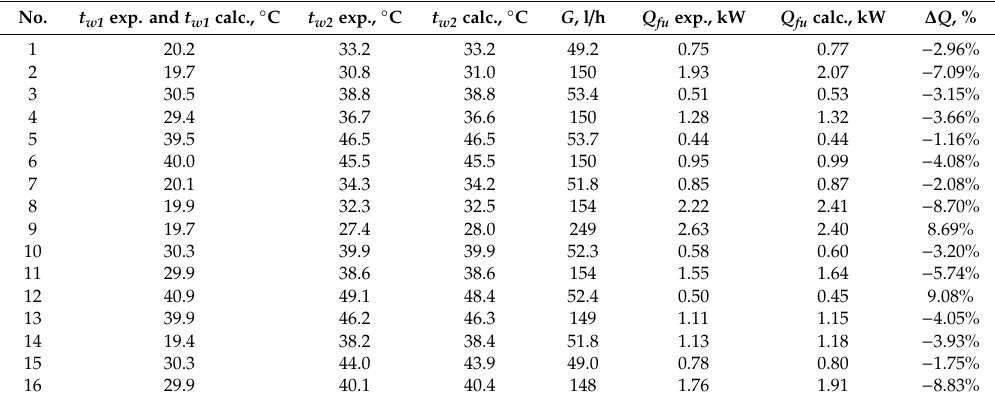
Table 1. Main parameters of the